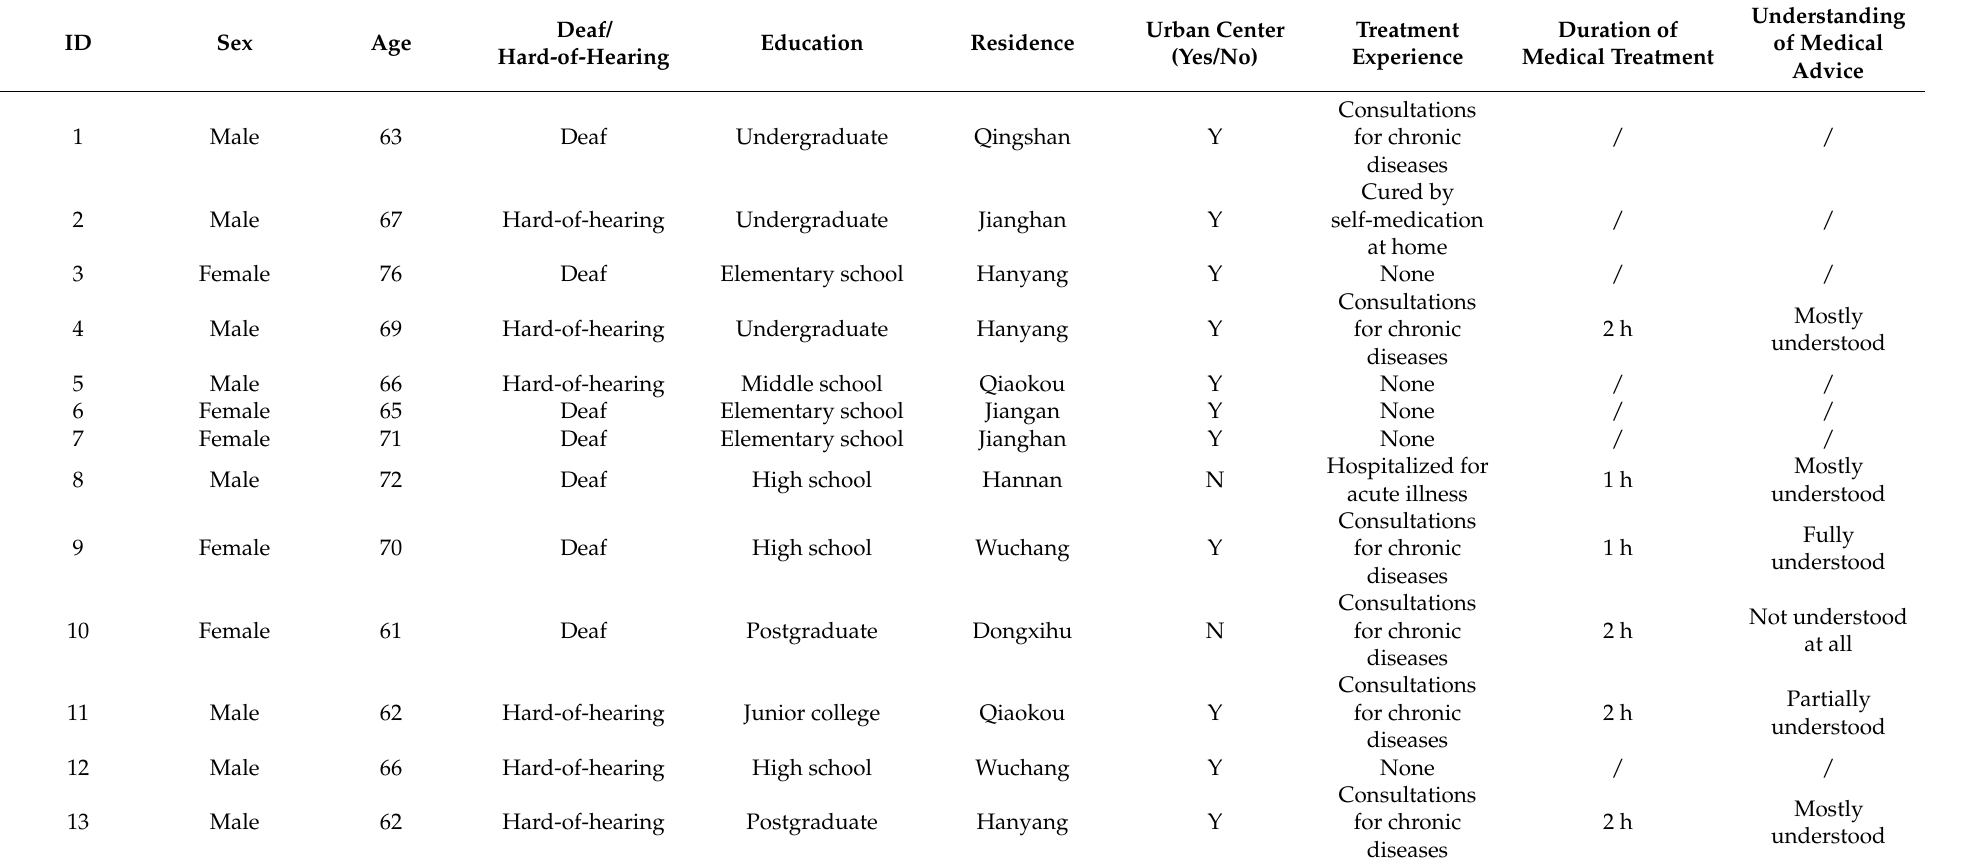
Table 1. Basic Characteristics of